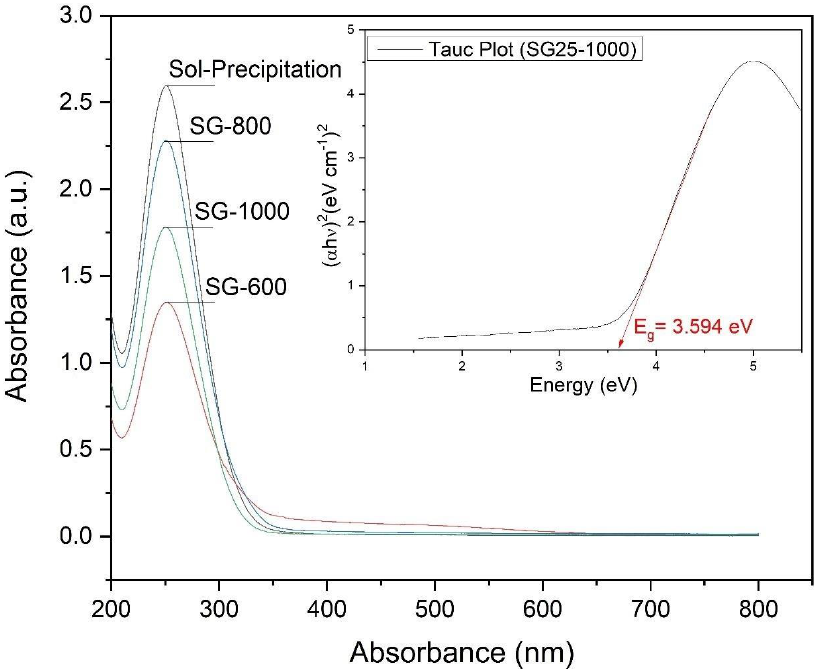
Figure 10. Graphics obtained from the UV-vis analysis of the powders synthesized by the sol-gel process at different temperatures (600 °C, 800 °C and 1000 °C) and by the sol-precipitation process.